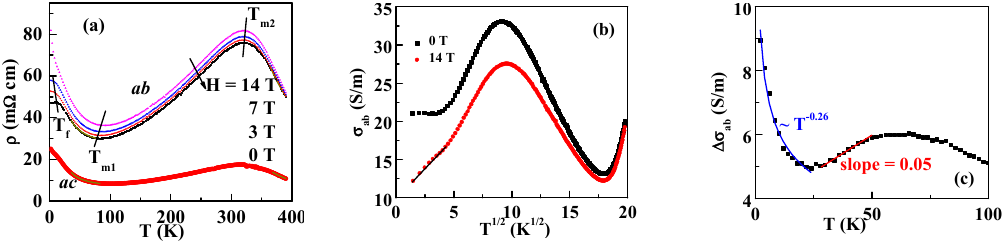
Figure 2. ( a ) Resistivity versus the temperature of RuSb 2 + on the ac plane ( ρ ac ) at 0 T and on the ab plane ( ρ ab ) at 0, 3, 7, and 14 T, ( b ) conductivity σ ab versus T , and ( c ) conductivity difference between 0 and 14 T. The solid symbols represent the experimental data, and the solid lines are fitting lines as described in the text.